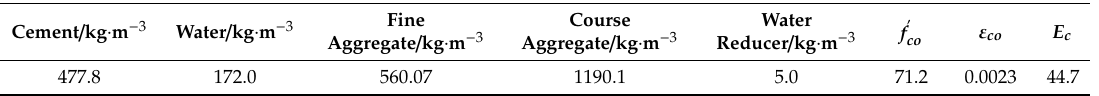
Table 1. Mix proportions of concrete.